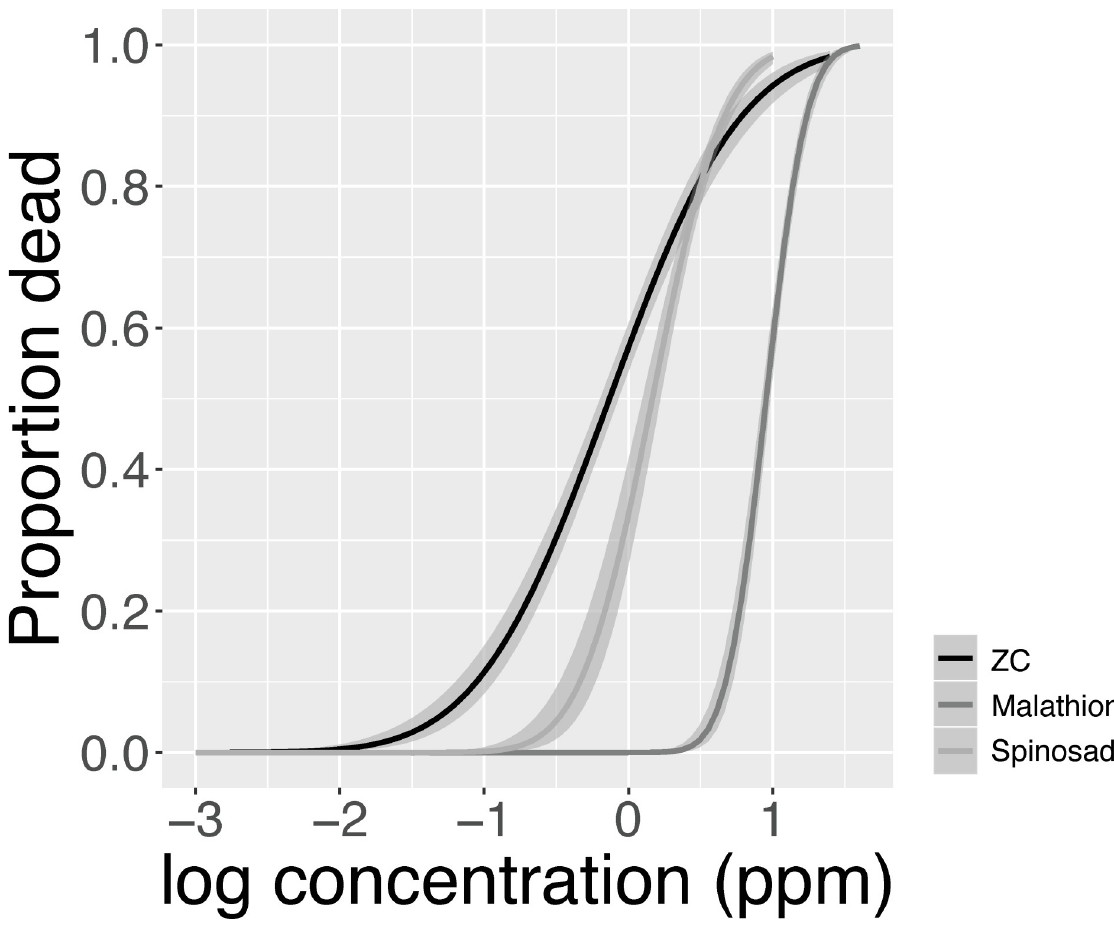
Fig 1. Dose-response relationships for susceptible D . suzukii larvae exposed to three key insecticides. Mortality was estimated following larval exposure to malathion, spinosad, and zeta-cypermethrin (ZC). Dose-response curves and 95% confidence intervals obtained from probit model.